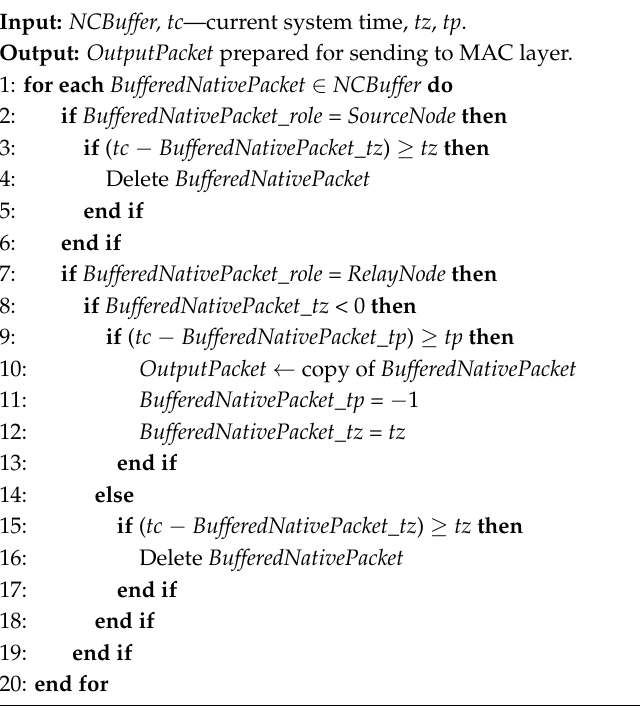
Algorithm 2. NC Buffer Timers